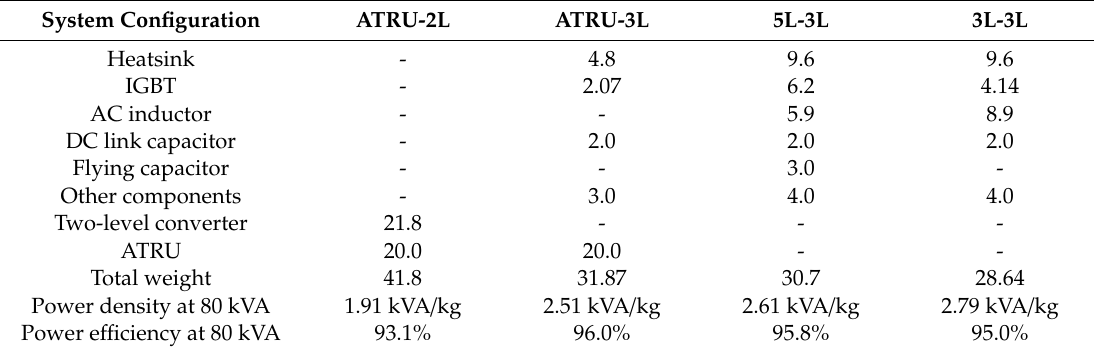
Table 8. Power density comparison between three possible system